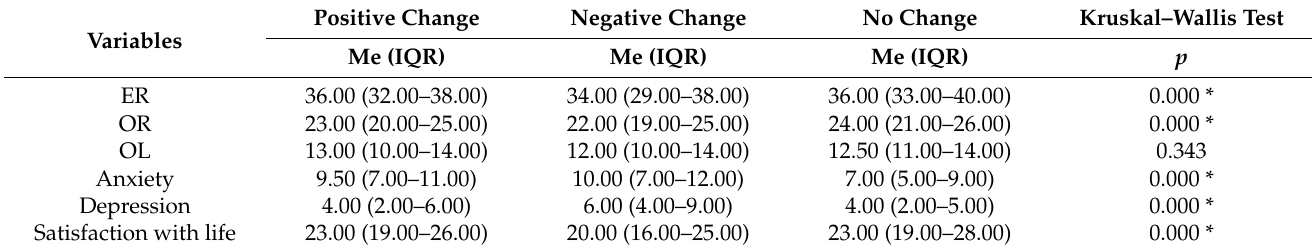
Table 3. Differences between changes in mental condition in the entire study